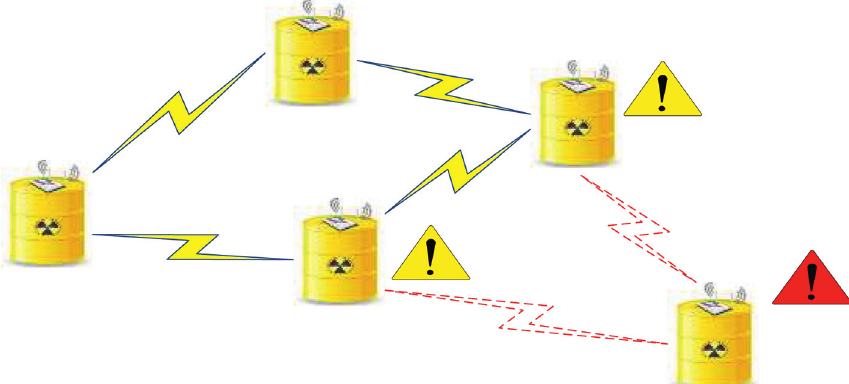
Figure 2: Schematic diagram of group perception and response.